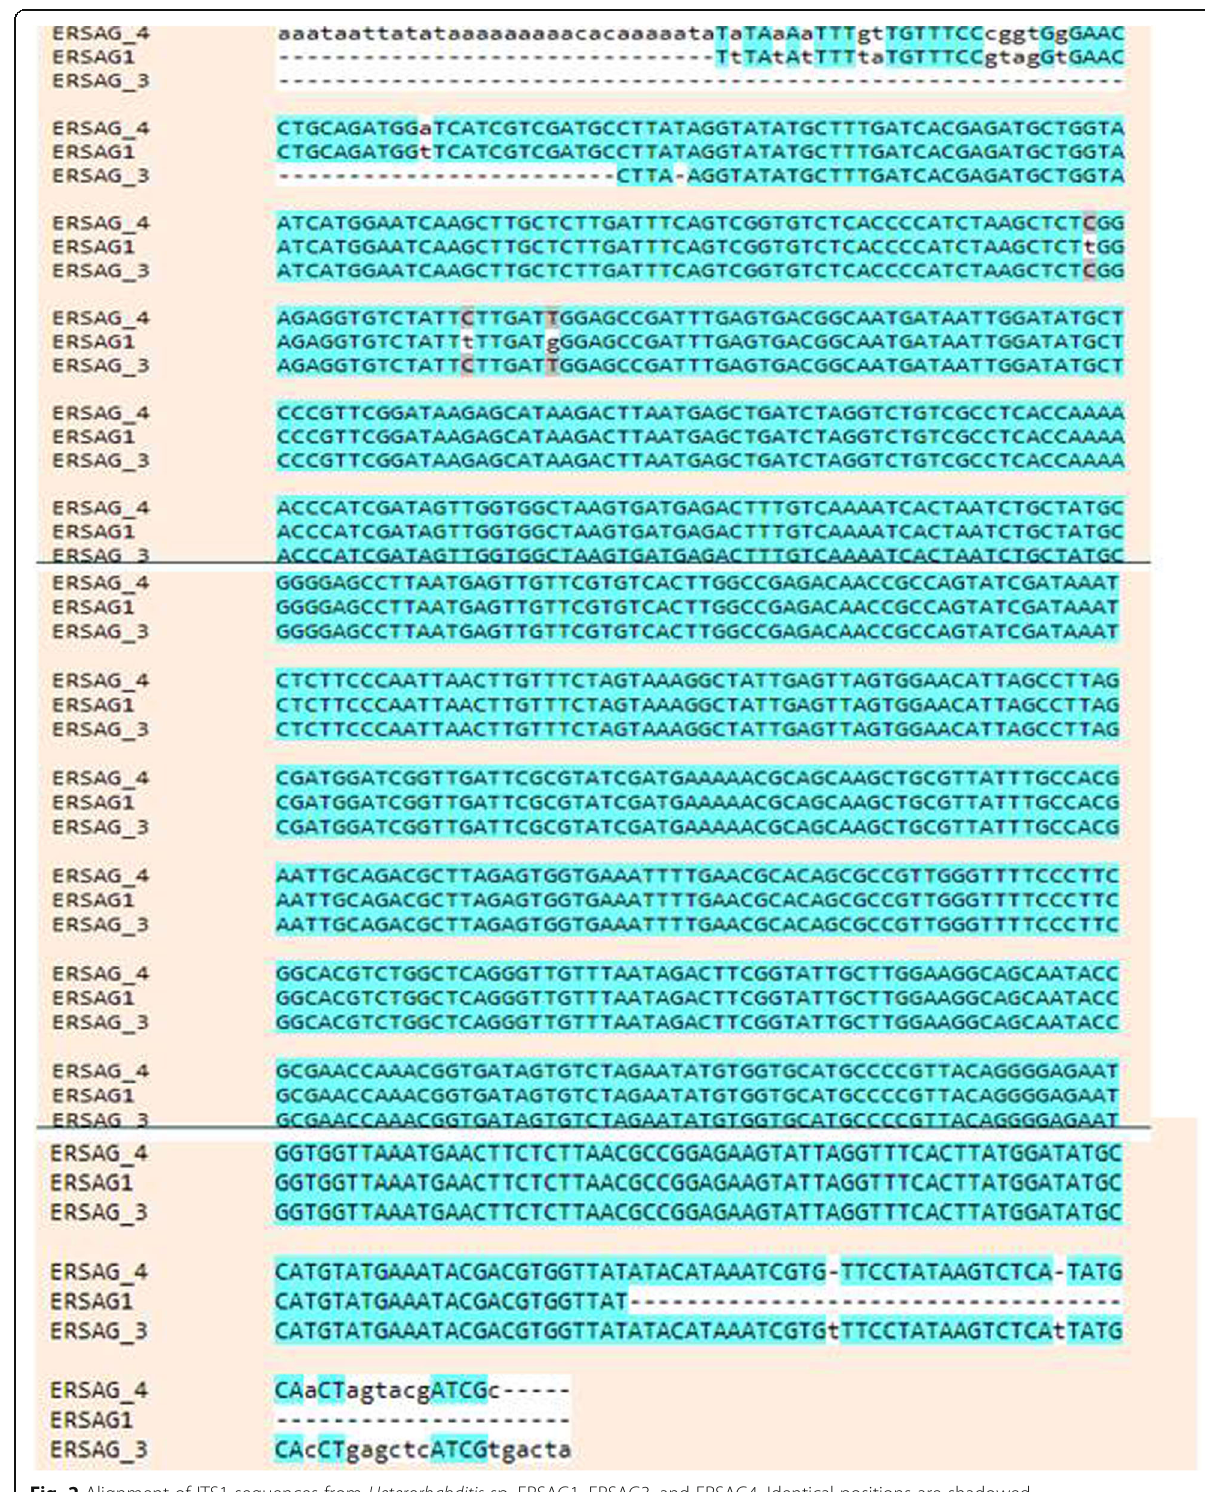
Fig. 2 Alignment of ITS1 sequences from Heterorhabditis sp. ERSAG1, ERSAG3, and ERSAG4. Identical positions are